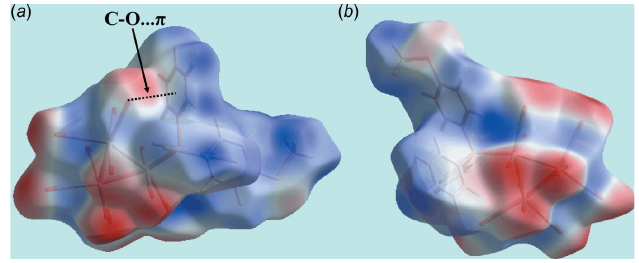
Figure 4 Two views of the Hirshfeld surface of (I) mapped over the electrostatic potential in the range (cid:7) 0.046 au. The red and blue regions represent negative and positive electrostatic potentials,